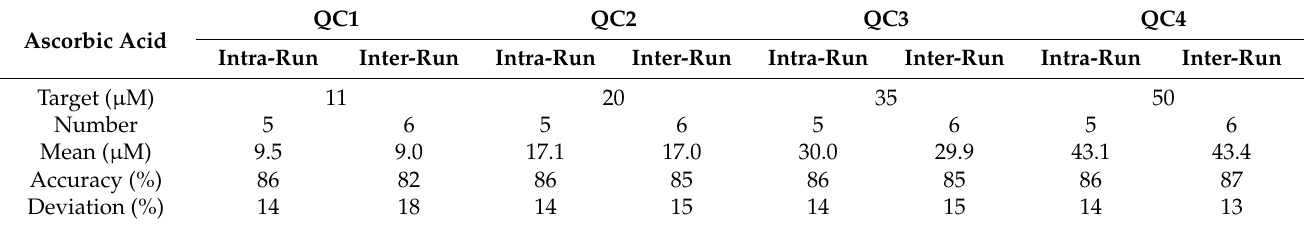
Table 3. Accuracy for AA measurement with HPLC. Target concentration (in µ M) is the required concentration of the quality control samples (QC1, QC2, QC3, QC4).